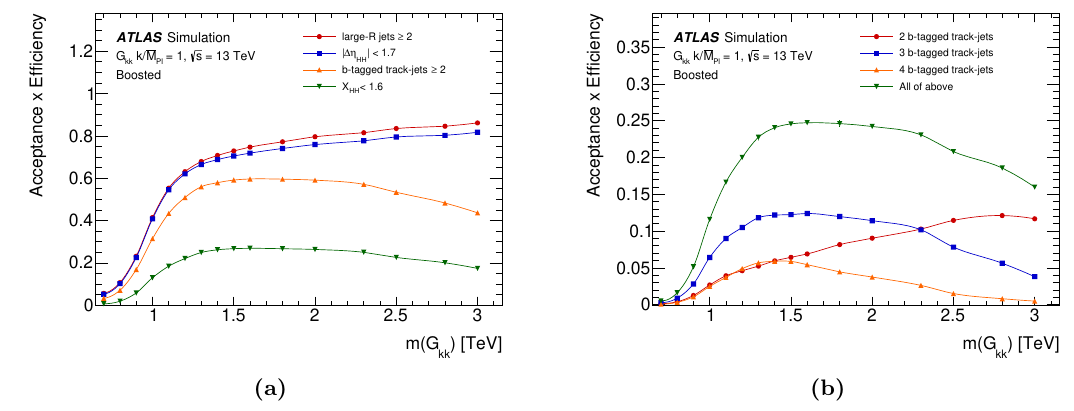
Figure 5. (a) The selection acceptance times e(cid:14)ciency of the boosted analysis at each stage of the event selection as a function of the generated graviton mass for k=M Pl = 1. The trigger e(cid:14)ciency is approximately 100% after the requirement of two large- R jets, so it is not shown. (b) The